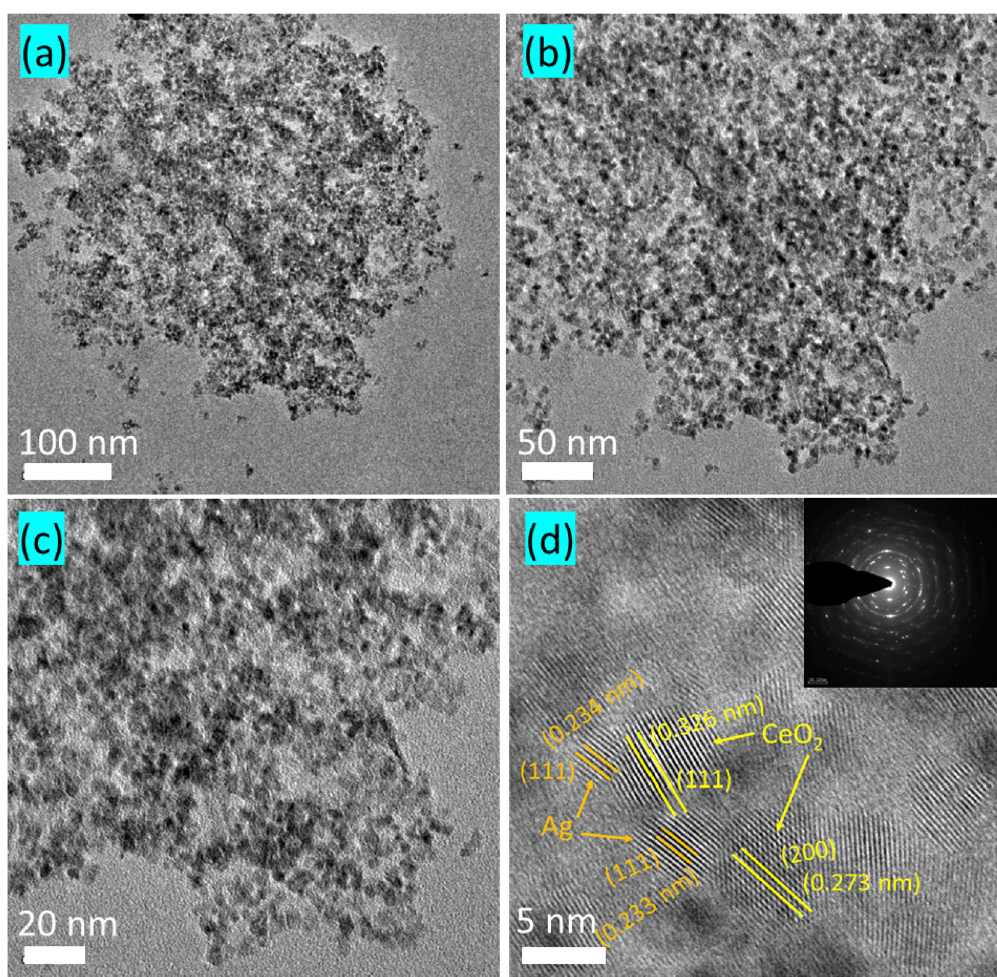
Figure 3. ( a – c ) HR-TEM analysis of Ag decorated CeO 2 nanoparticles with different magnifications. ( d ) Shows high magnification of HR-TEM images with well-resolved lattice springs and SAED pattern (insert) of Ag decorated CeO 2